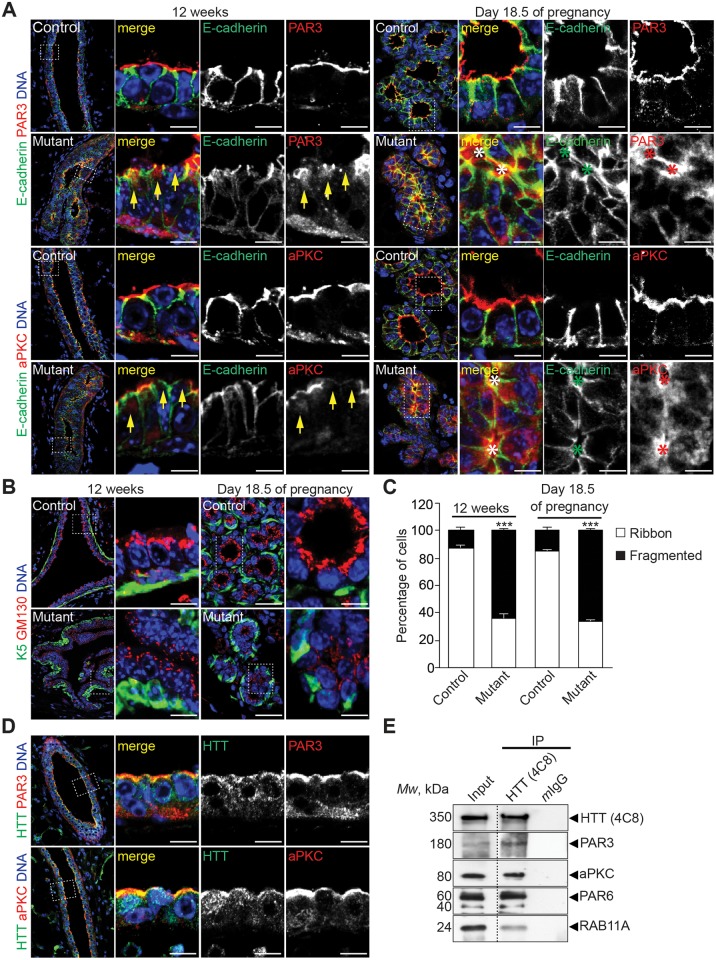
HTT is required for apical localization of PAR3 and aPKC in vivo.(A) Mammary gland sections stained for E-cadherin and PAR3 or aPKC. Arrows indicate cytoplasmic accumulation and impaired localization of PAR3 and aPKC to the apical surface; asterisks indicate small lumens. (B) Mammary gland sections stained for keratin 5 (K5) and GM130. (C) Percentage of LCs showing ribbon-like and fragmented localization of GM130 (control: n = 4 mice; mutant: n = 4 mice). (D) Mammary gland sections stained for HTT 4C8 and PAR3 or aPKC. (E) HTT/PAR3/PAR6/aPKC/RAB11A complexes were immunoprecipitated from MCF-10A cells. Mouse IgG (mIgG) was used as a negative control. The immunoprecipitates (IP) were analyzed by western blotting. All scale bars, 10 μm. Error bars, SEM. *** p<0.001. Complete statistical analyses with number of measures are detailed in S1 Data.